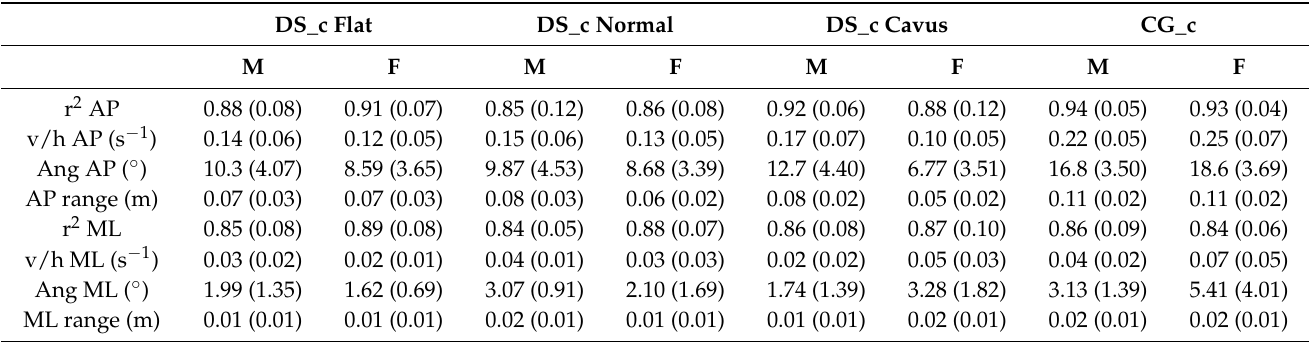
Table 2. Mean and standard deviation values of parameters extracted from the CoP in the antero– posterior (AP) and medio–lateral (ML) directions for healthy children and children with Down syndrome (DS). M, males; F, females; r 2 , coefficient of determination; v/h, mean velocity of the CoP normalized with respect to height; Ang, angle of inclination of the line interpolating the displacement of the analyzed CoP; range, range of the CoP (max coordinate–min